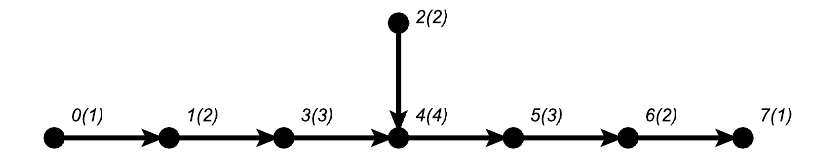
Figure 3. Oriented b E 7 quiver. The numbers in the parentheses represent the Coxeter labels d i